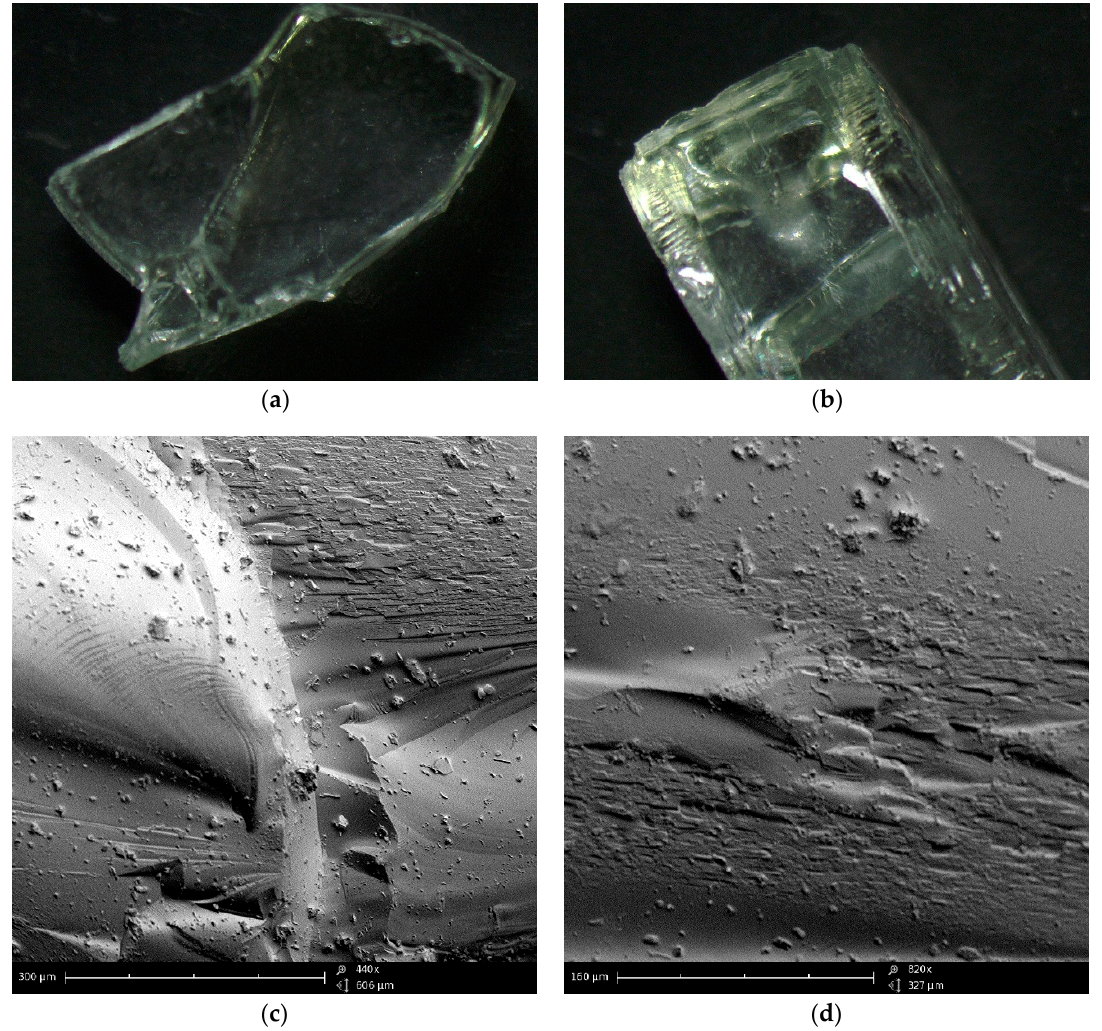
Figure 7. Grain of the recycled glass aggregate: ( a,b ) under the optical microscope; ( c ) SEM image (magnification ×440); ( d ) SEM image (magnification ×820).